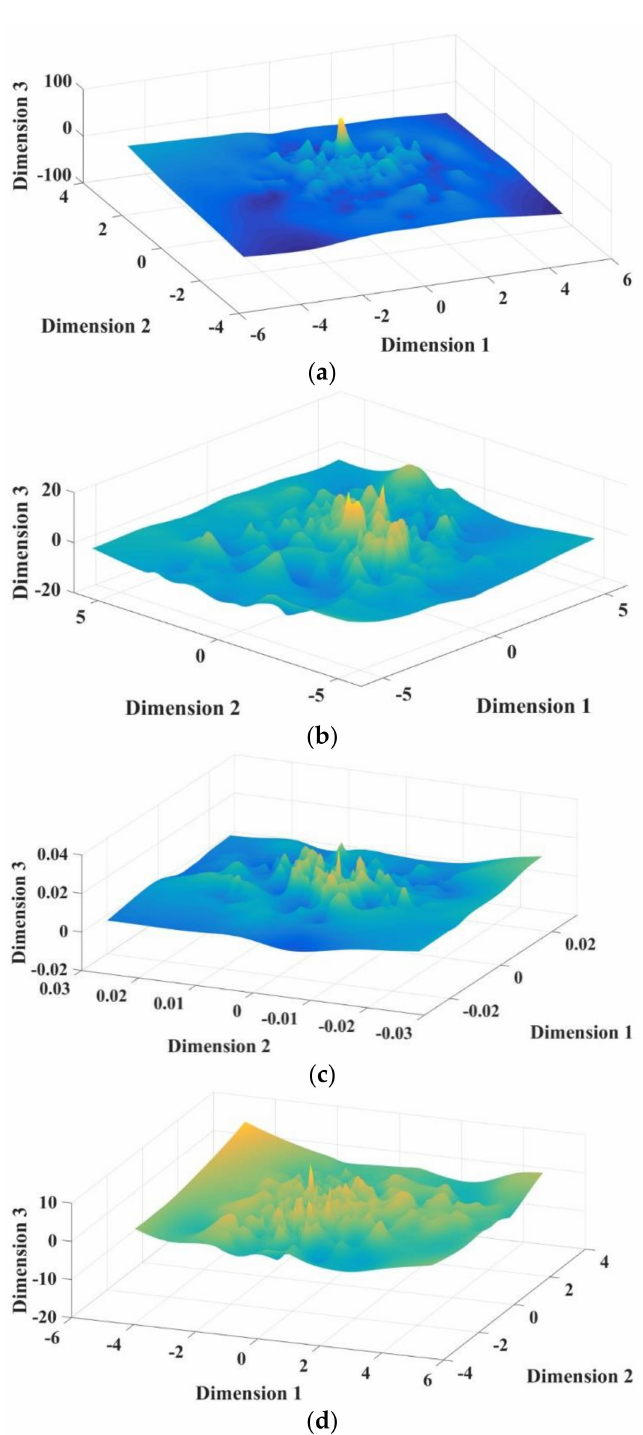
Figure 7. 3D surface graph of three-dimensional features extracted by each algorithm. ( a ) Three-dimensional features extracted by principal component analysis (PCA); ( b ) Three-dimensional features extracted by t-distributed stochastic neighbor embedding (t-SNE); ( c ) Three-dimensional features extracted by Autoencoder; ( d ) Three-dimensional features extracted by Treelet Transform. The fault samples are classified into four types by Gaussian process classifier. Since ten-fold cross-validation has good performance [20], it is used in this paper. The average accuracy and standard deviation comparison between different methods is shown in Table 1. Method 4 is the method proposed in this paper, which has the minimum standard deviation and almost the maximum